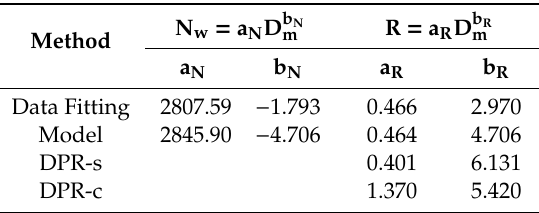
Figure 6. Power-law regressions of N w –D m ( left ) and R–D m ( right ) relations obtained from the DSD data. Similar to top panel of Figure 5, the color graphs represent PDFs of the data. Table 1. Coefficients of the power-law N w –D m and R–D m relations derived from the DSD data and the DSD models as well as the R–D m relations adopted by the DPR operational algorithm.